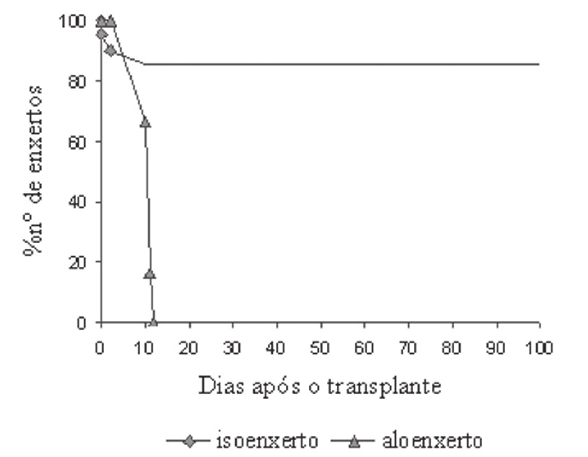
Fig. 3 – Gráfico de sobrevida dos enxertos cardíacos: 22 isotransplantes e 24 alotransplantes